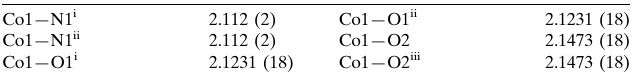
Selected bond lengths (A˚ ).